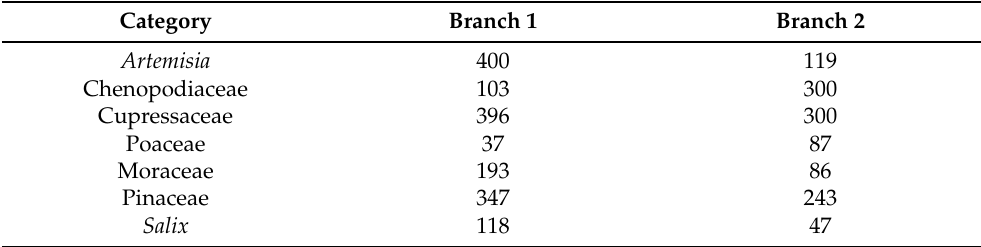
Table 4. The experimental statistics of each branch.